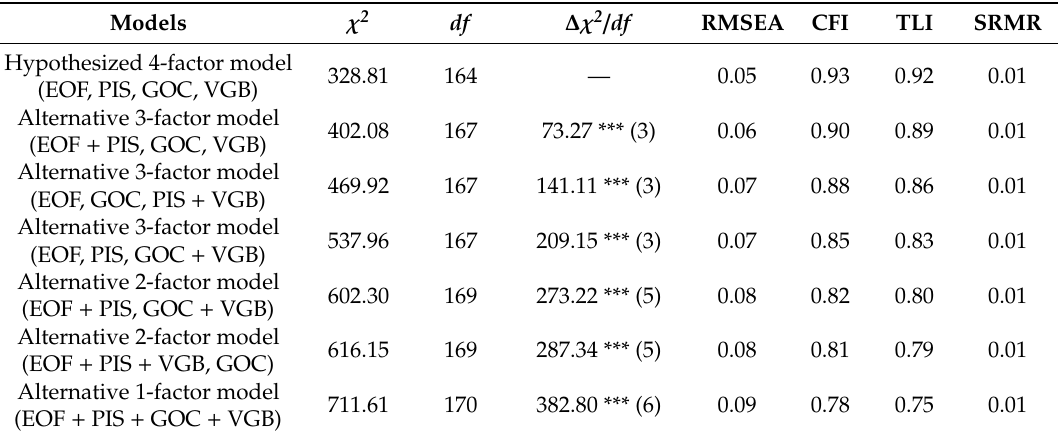
Table 1. Measurement model fit results.